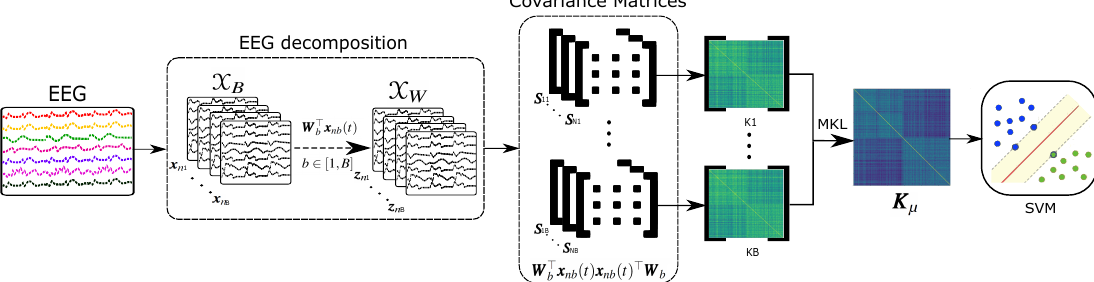
Figure 2. Proposed EEG classification methodology based on filter-banked Stein-kernel trial